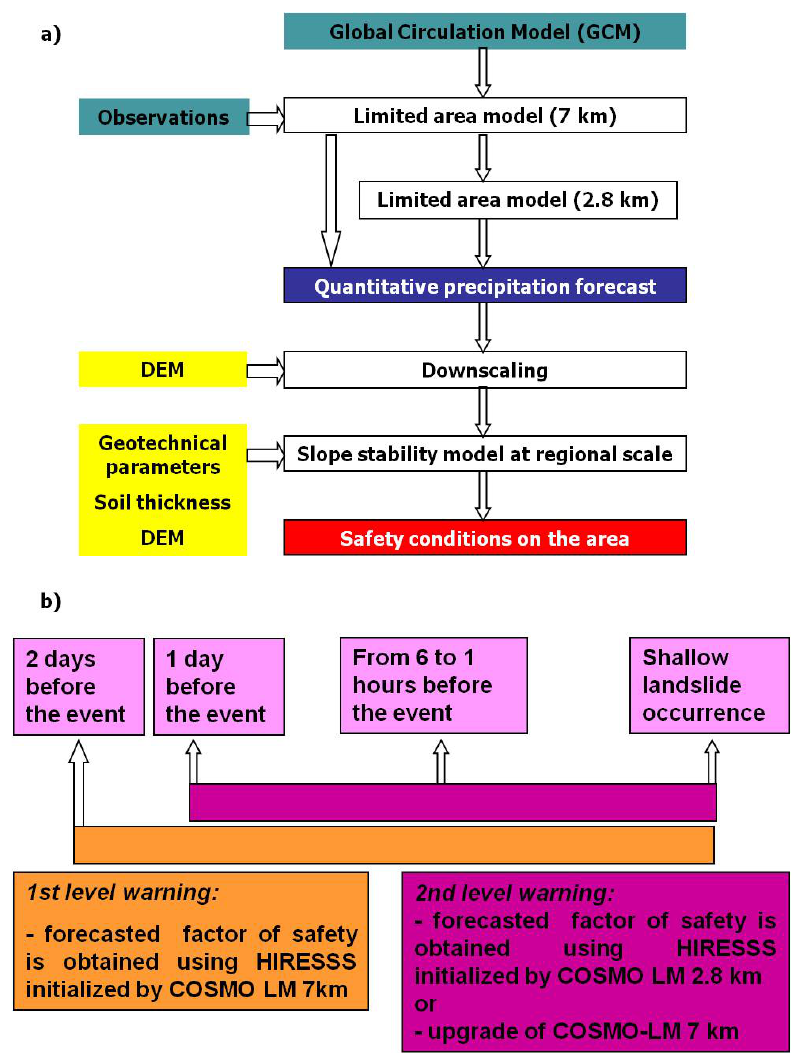
Fig. 1. Flow chart of the simulation chain (a) and time windows of the prototype warning system (b)